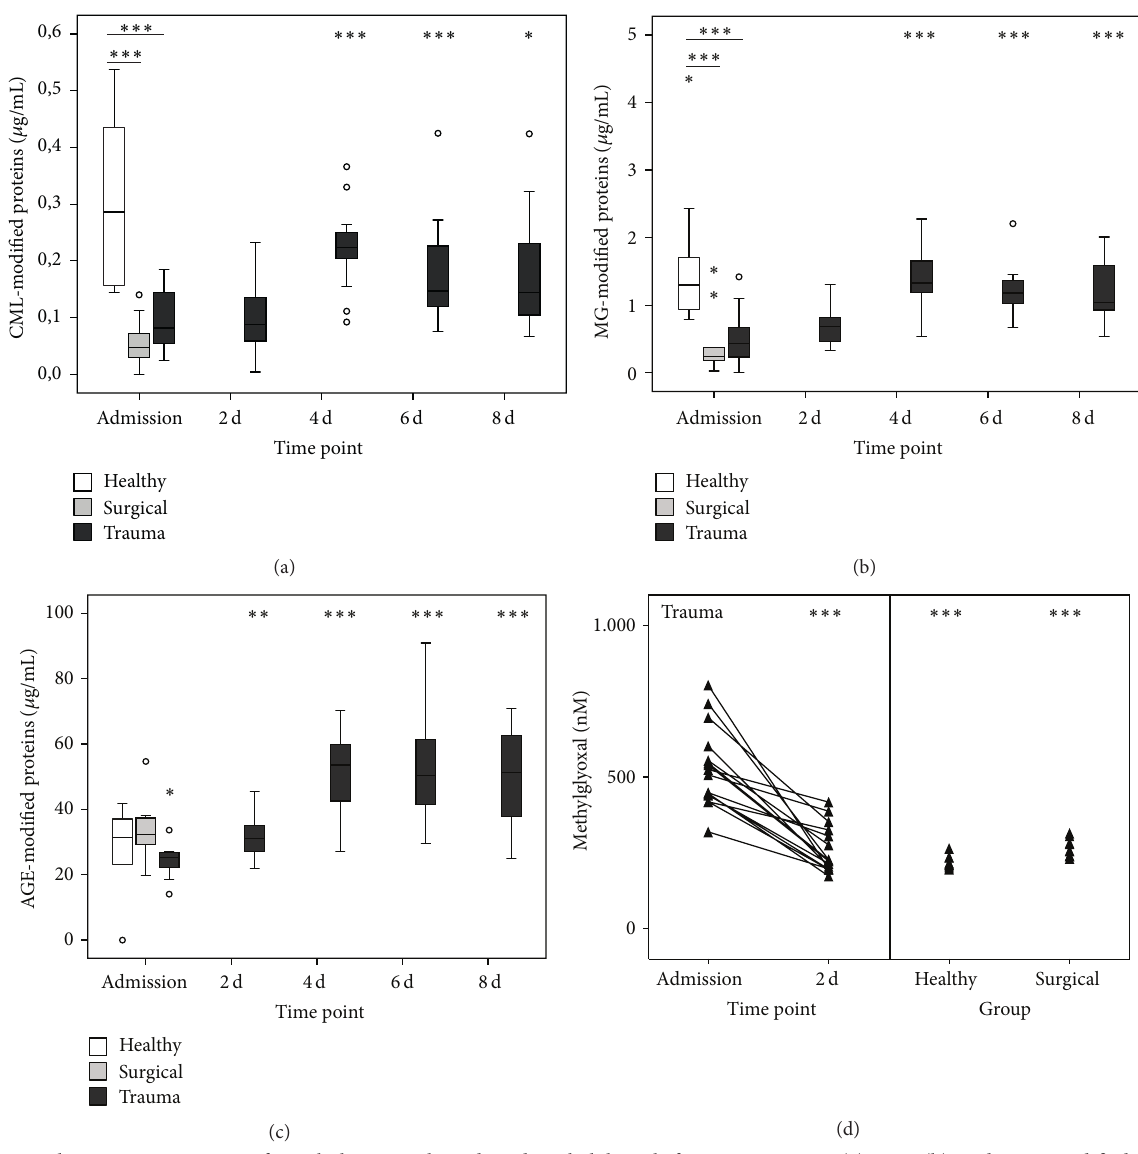
Figure 4: Plasma concentrations of metabolic RAGE ligands and methylglyoxal after trauma. CML- (a), MG- (b), and AGE-modified protein (c) and methylglyoxal (d) levels at admission ( 𝑛 = 16 /10/10 for trauma/surgical/healthy) and 2 d ( 𝑛 = 16 ), 4d ( 𝑛 = 15 ), 6d ( 𝑛 = 11 ), and 8 d after trauma ( 𝑛 = 11 ). ∗ 𝑃 < 0.05 , ∗∗ 𝑃 < 0.01 , and ∗∗∗ 𝑃 < 0.001 compared to trauma at admission (Mann-Whitney 𝑈